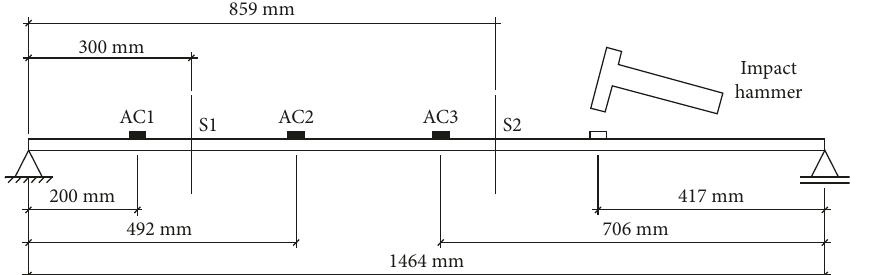
Figure 4: Illustrative sketch of accelerometers AC1, AC2, and AC3 and impact hammer positions along the structure. Table 2: Experimental modal results for A1 and A2 configurations 2 )). (damping rates (10 −